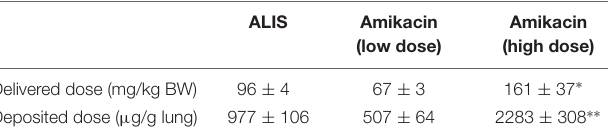
TABLE 2 | Delivered and deposited amikacin doses in rats administered either ALIS or free amikacin by nebulization.